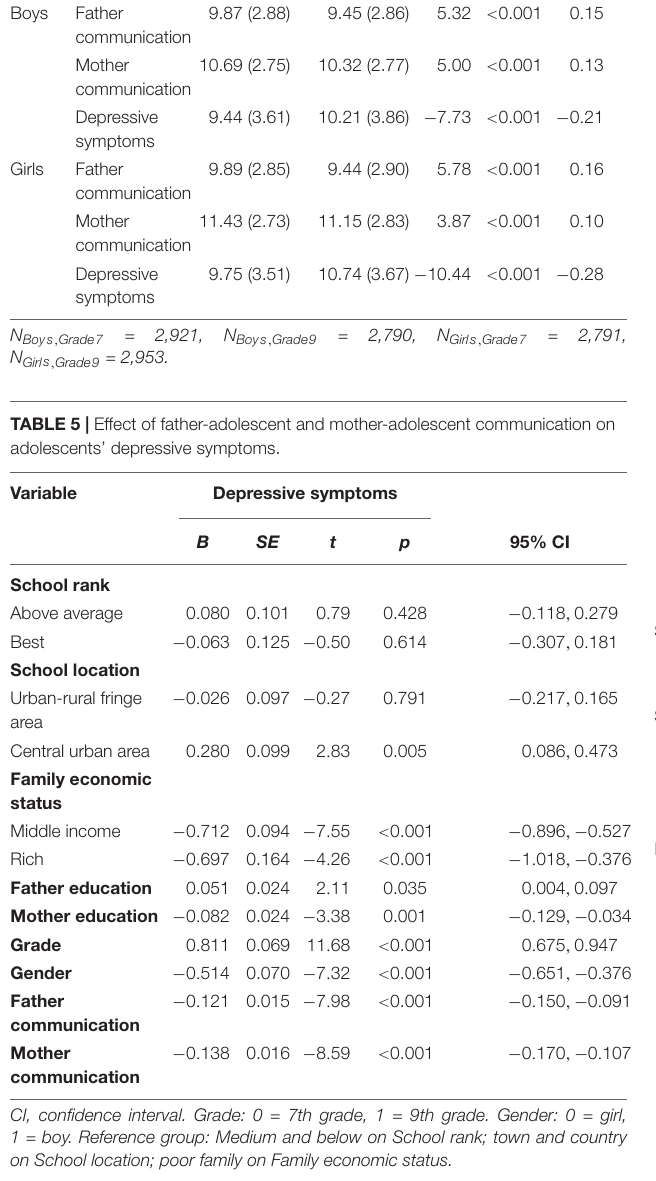
TABLE 4 | Means and standard deviations of parent-adolescent communication and depressive symptoms according gender and grade.